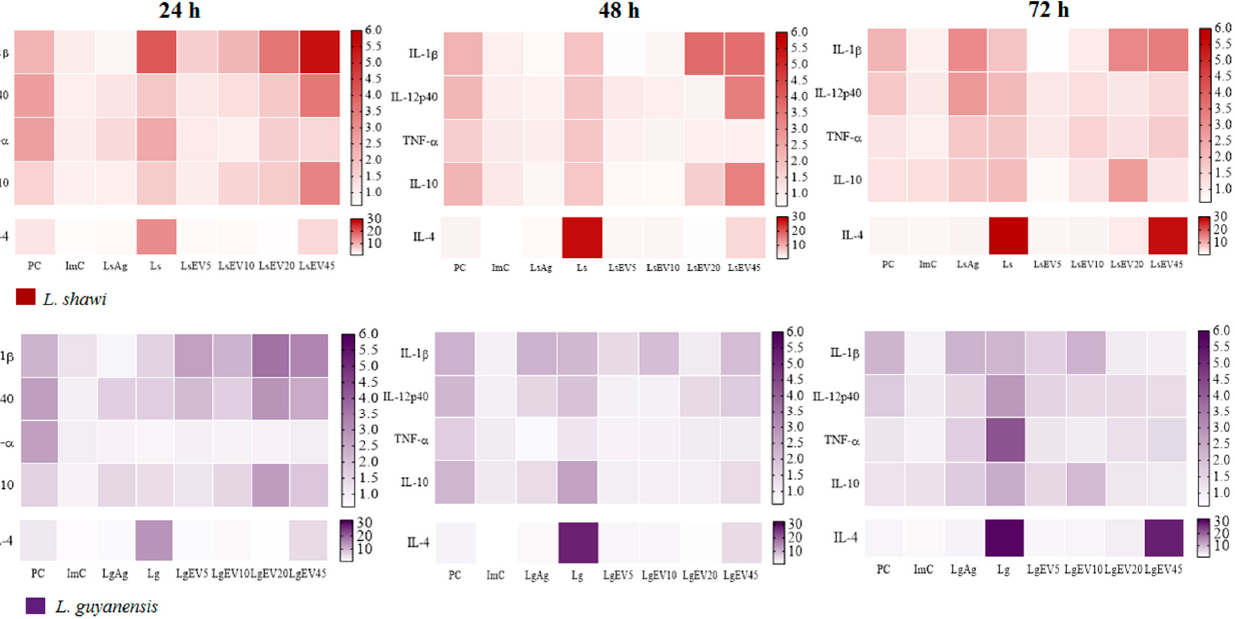
Figure 8. E ff ect of L. shawi and L. guyanensis EVs on cytokines gene expression. M Ф incubated for 24 h, 48 h, and 72 h with 5 (LsEV5; LgEV5), 10 (LsEV10; LgEV10), 20 (LsEV20; LgEV20), and 45 µg·mL − 1 (LsEV45; LgEV45) of EVs from L. shawi (red) and L. guyanensis (purple), parasite antigens (LsAg and LgAg), and L. shawi (Ls) and L. guyanensis (Lg) promastigotes were analyzed by RT-qPCR. Results normalized to resting M Ф are represented by heat maps of three independent assays performed in triplicate. PC—positive control (M Ф incubated with PMA); ImC—M Ф incubated with negative control of EV isolation method.